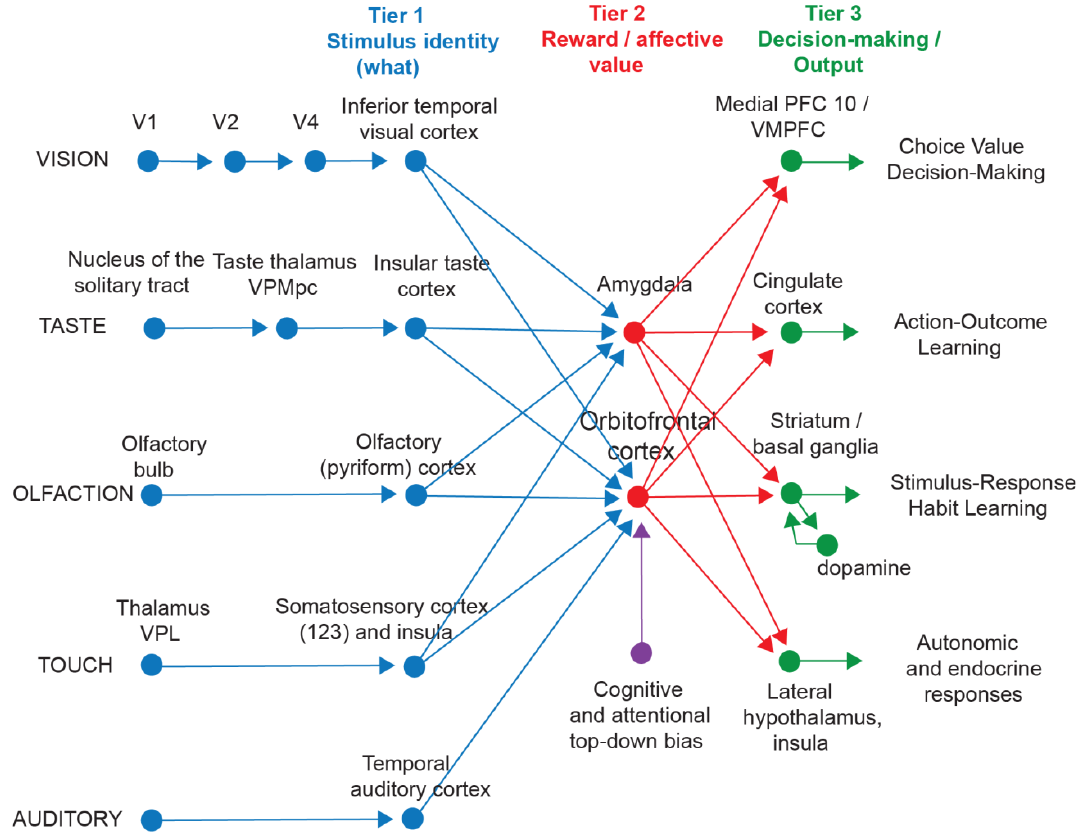
Figure 2 : Schematic diagram showing some of the connections of the taste, olfactory, somatosensory, and visual pathways in the brain. V1, primary visual (striate) cortex; V2 and V4, further cortical visual areas. PFC, prefrontal cortex. The Medial PFC area 10 is part of the ventromedial prefrontal cortex (VMPFC). VPL, ventro-postero-lateral nucleus of the thalamus, which conveys somatosensory information to the primary somatosensory cortex (areas 1, 2 and 3). VPMpc, ventro-postero-medial nucleus pars parvocellularis of the thalamus, which conveys taste information to the primary taste cortex. For purposes of description, the stages can be described as Tier 1, representing what object is present independently of reward value; Tier 2 in which reward / affective value is represented; and Tier 3 in which decisions between stimuli of different value are taken, and in which value is interfaced to behavioural output systems. A pathway for top-down attentional and cognitive modulation of emotion is shown in purple. Auditory inputs also reach the